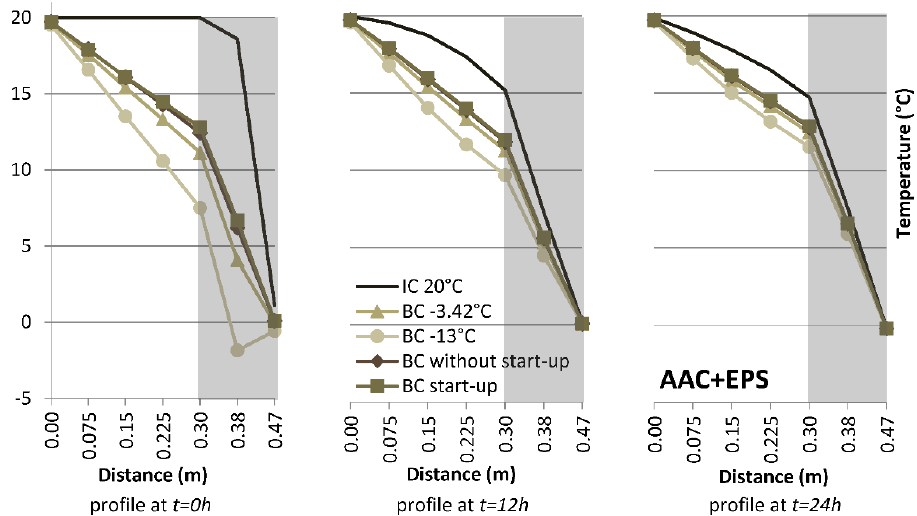
Figure 14. Temperature profile across the outdoor test cell wall (AAC + EPS) at time t = 0 h, t = 12 h and t = 24 h for five cases under the initial condition. Abbreviations IC and BC refers to Section 2.4.